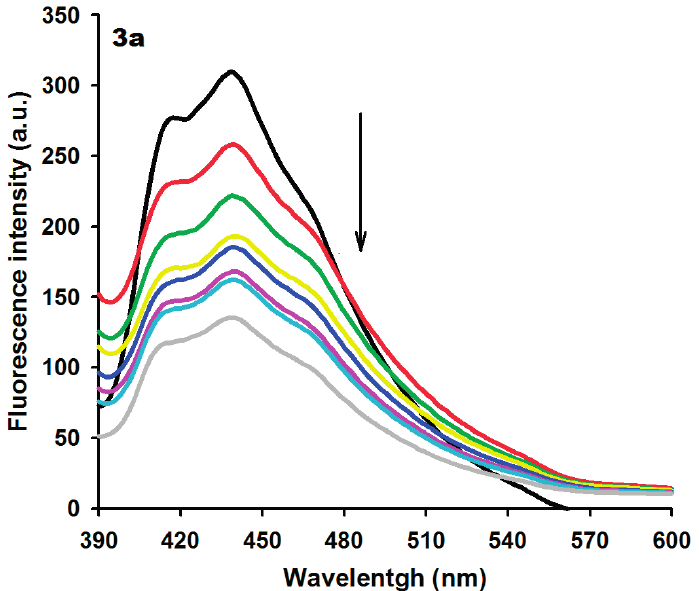
Figure 2. Fluorescence spectra of derivative 3a (15 µM) with increasing concentrations of ctDNA. [DNA] = 0 (black), 10 (red), 20 (green), 40 (yellow), 60 (blue), 80 (pink), 100 (light blue) and 120 (gray) µM. Arrow ( ↓ ) refers to hypochromic